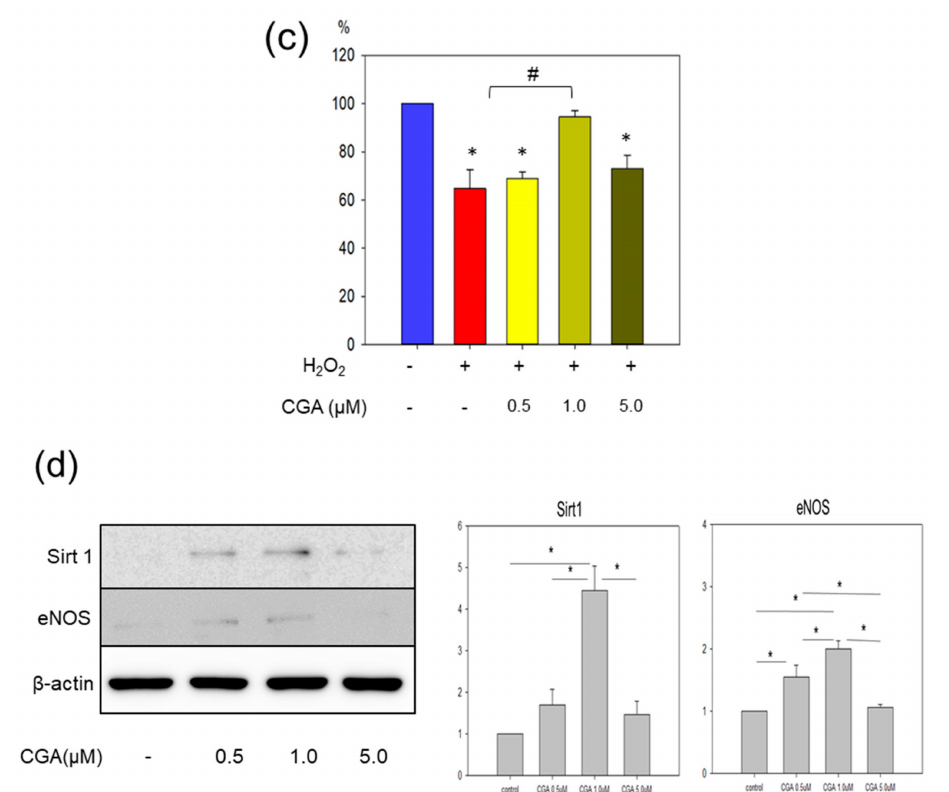
Figure 2. E ff ects of CGA on HUVECs. ( a , b ) Immunostaining of ( a ) 8-OHdG, ( b ) SA- β -gal staining, and ( a , b ) morphological changes Original magnification × 200. * p < 0.05 ( n = 6) Each bar presents the mean ± SE of six experiments; ( c ) Cell proliferation was determined using a CCK-8 kit. * p < 0.05 vs. CGA- / H 2 O 2 - , # p < 0.05 ( n = 3) Each bar presents the mean ± SE of three experiments; ( d ) Protein expression of Sirt1 and eNOS in CGA-treated HUVECs. * p < 0.05 ( n = 3) Values represent the means ± SE of three experiments.